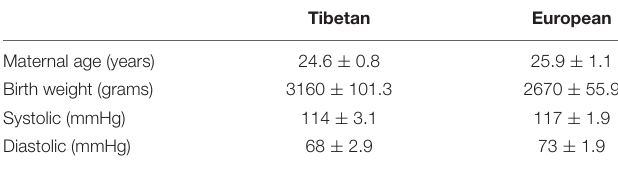
TABLE 1 | General